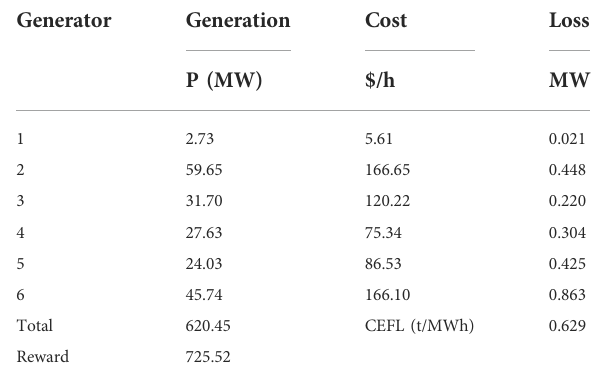
TABLE 11 The dispatching results OF OPF. TABLE 12 The dispatching results of DRL-based